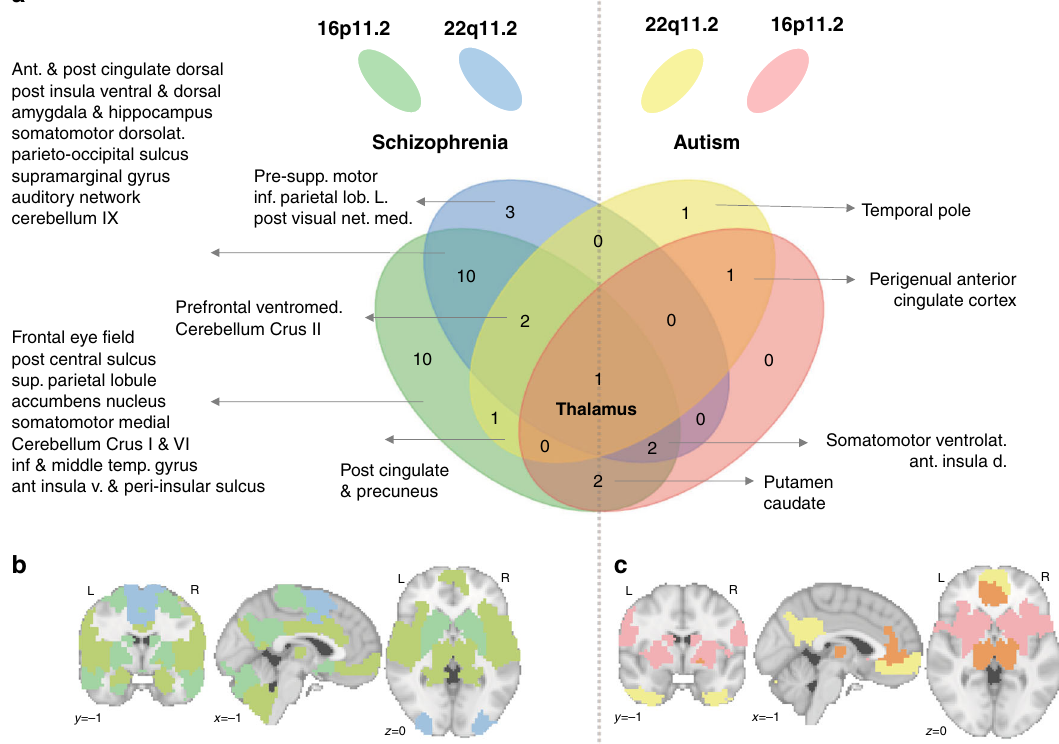
Fig. 4 Regional FC similarity between psychiatric diagnoses and deletions. The FC-signatures of both deletions are decomposed into 64 seed-regions. Deletion FC-signatures are correlahe individual connectivity pro fi le of subjects with a psychiatric diagnosis and their respective control subjects. Of note, the correlation is equivalent to the mean centering of all region-based FC-signatures. Signi fi cantly higher similarities of patients with either ASD and SZ were present in 33 seeds regions (FDR) and are presented on the right and the left side of the Venn diagram, respectively ( a ), and also in the corresponding left ( b ) and right ( c ) brain maps. At the intersection of all ellipses, the thalamus FC-signatures of both deletions showed increased similarity with individuals who have a diagnosis of ASD or SZ compared to their respective controls. 16pDel 16p11.2 deletion, 22qDel 22q11.2 deletion, Ant anterior, Post posterior, dorsolat dorsolateral, Inf inferior, L. left, v. ventral, net. network, med medial, Supp supplementary, lob lobule (Full-name labels are provided in Supplementary Data